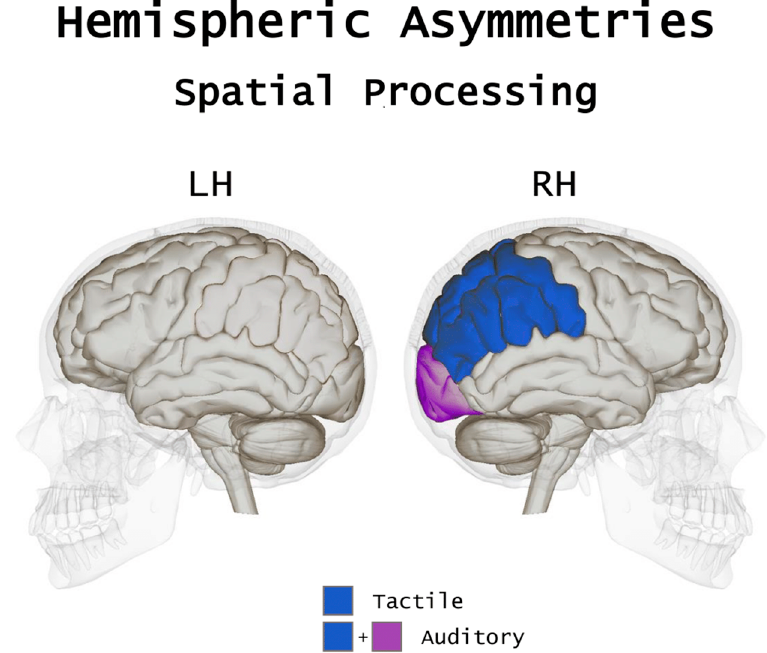
Figure 2. A pictorial, simplified view of the hemispheric asymmetries subserving spatial processing in the blind. In spatial tasks, in addition to a robust activation of parietal areas in tactile spatial processing, the blind also show a cross-modal recruitment of the occipital lobe, especially in auditory and tactile localization tasks.